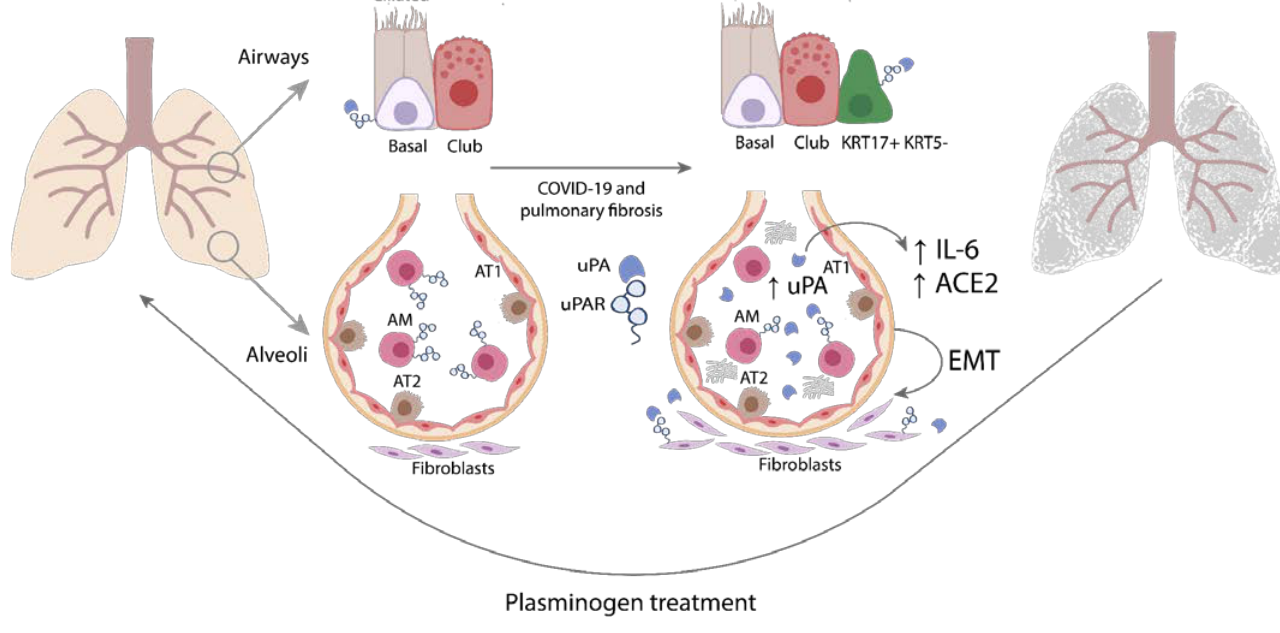
Figure 10. The putative scheme of COVID-19-induced pulmonary fibrosis regulation by uPA/uPAR system. In control conditions, only the epithelial basal airway cells express uPA and uPAR, while lung monocytes/macrophages express a considerable amount of uPAR. COVID-19 and pulmonary fibrosis result in uPA and uPAR downregulation in basal cells, uPAR downregulation in lung mon- ocytes/macrophages, and the appearance of pro-fibrogenic KRT17+ KRT5- cells and fibroblasts that express both uPA and uPAR. Additionally, pulmonary fibrosis is associated with the emergence of some alveolar and monocyte-derived macrophages that express uPA. The consequences of uPAR downregulation involve uPA accumulation due to the defects in its internalization and lysosomal degradation. Pro-fibrogenic uPA accumulation in the absence of uPAR leads to IL-6 and ACE2 up- regulation and EMT. Excessive lung fibrosis induced by low uPAR levels and the accumulation of inactive uPA can be resolved by plasminogen treatment. AT1 and AT2, alveolar type I and type II cells; AM, alveolar macrophages; EMT, epithelial–mesenchymal transition.